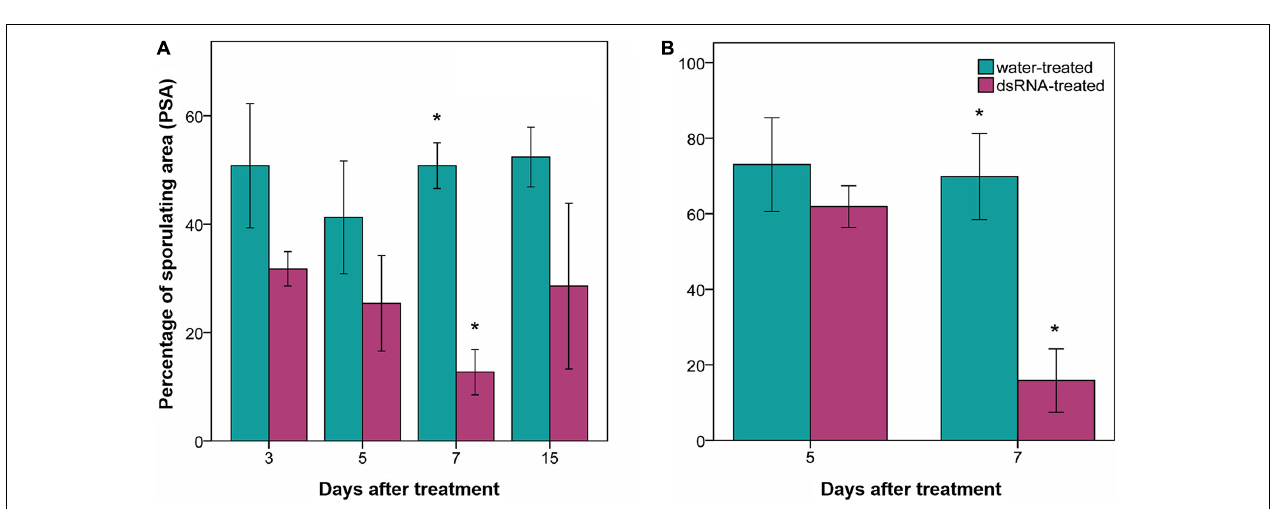
FIGURE 2 | Effect of dsRNA treatment on VviLBDIf7 gene expression. VviLBDIf7 gene expression analysis determined based on the 2 − (cid:49)(cid:49) Ct method at 3, 5, 7, and 15 days after treatment (dat) on Pinot noir plants grafted onto SO4 (A) , and at 5 and 7 dat on self-rooted Pinot noir plants (B) . Bars represent standard errors. Asterisks indicate statistically significant differences among the dsRNA- and water-treated conditions at each time point (* p value = 0.05).